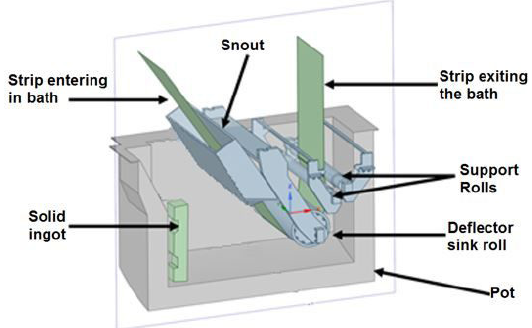
Figure 2. Mesh structure of polyhedral elements for zinc bath and